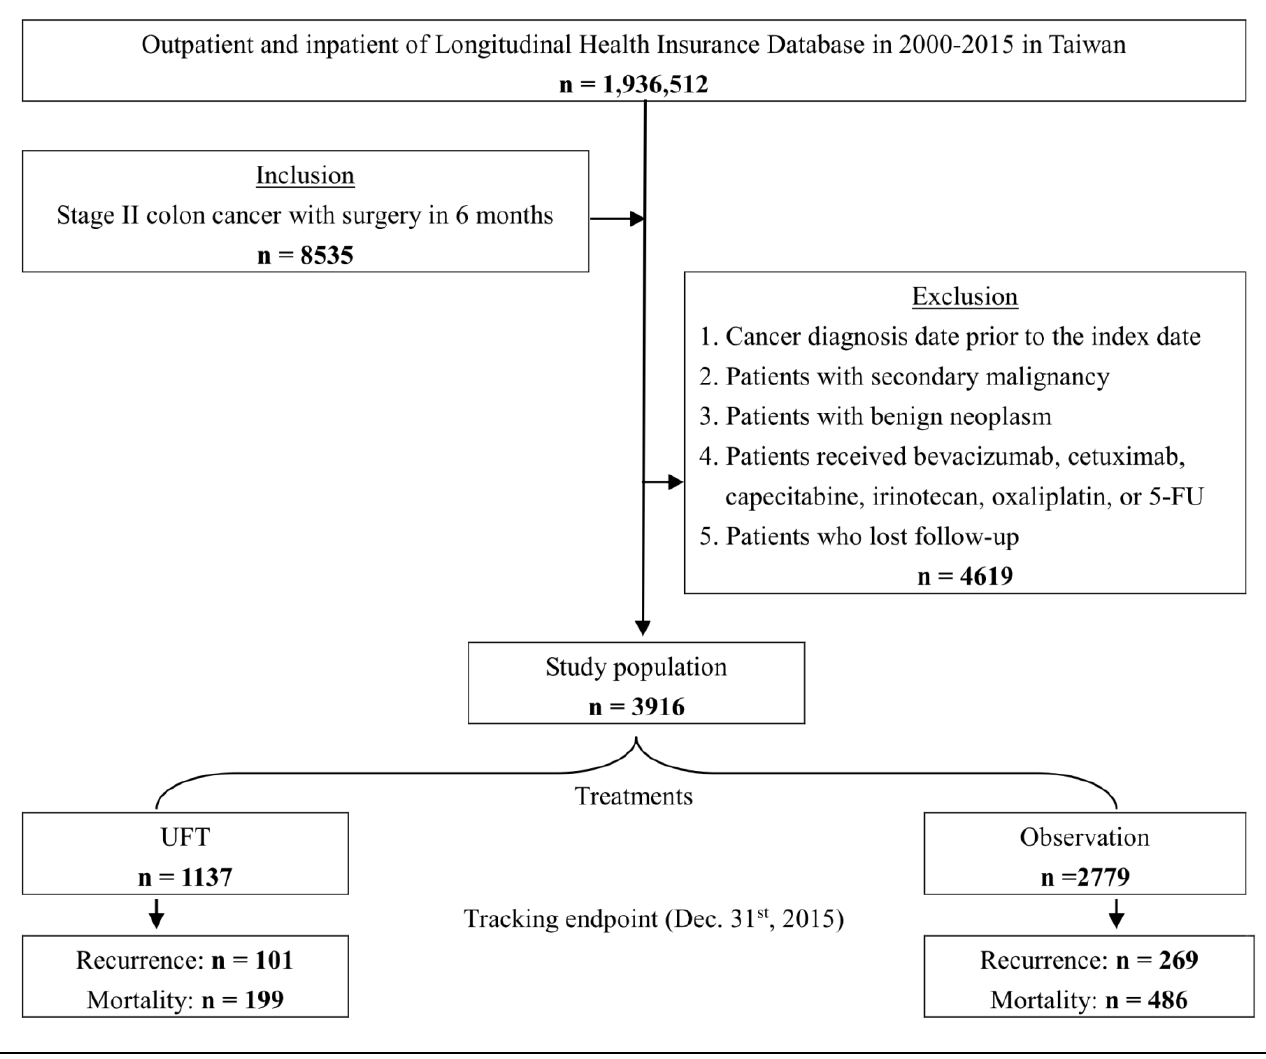
Figure 1. A flow chart of the recruitment of the subjects.